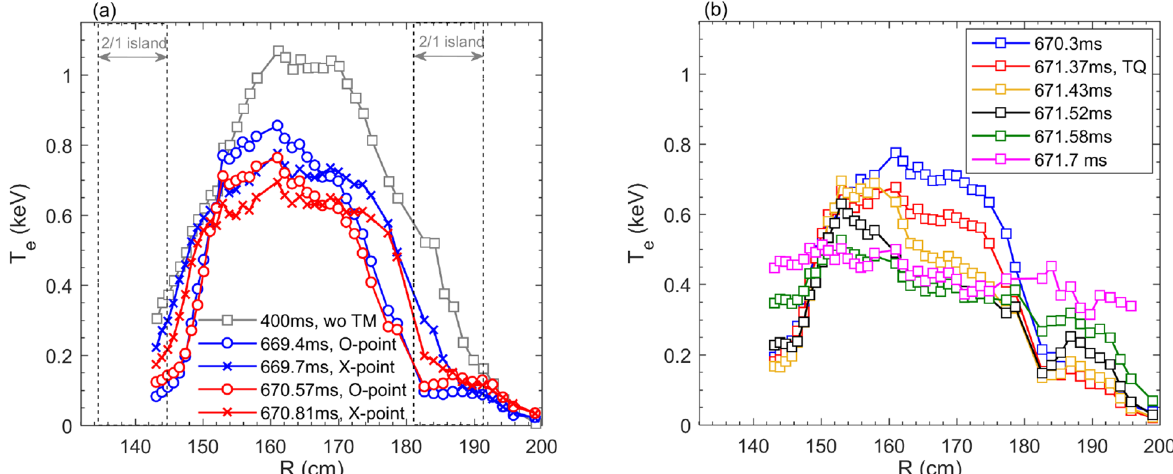
Figure 6. ( a ) T e profiles without tearing mode (squares), X- (blue crosses) and O-point (blue circles) phases before the small collapse, and X- (red crosses) and O-point (red circles) phases after the small collapse. The 2/1 island region is marked in the figure; ( b ) T e profiles between TQ and CQ (#33432).